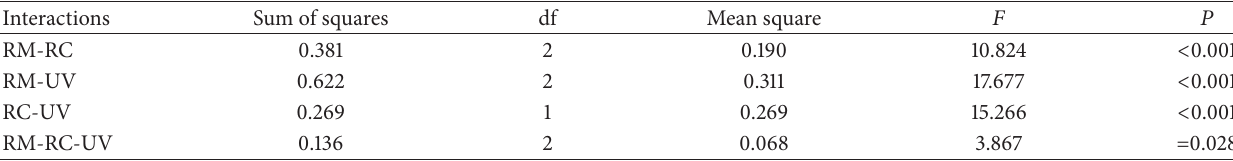
Table 2: Three-way ANOVA table for interactions of Ra values.